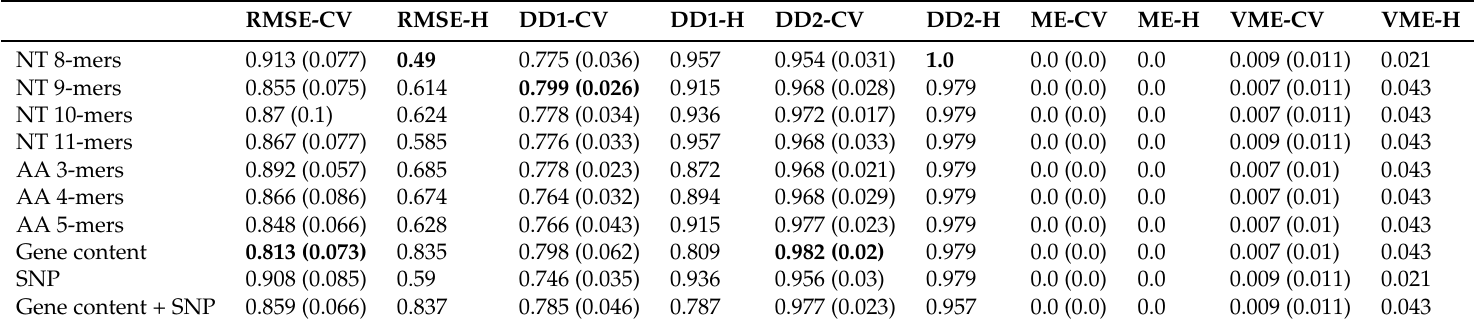
Table A15. C. jejuni –clindamycin.